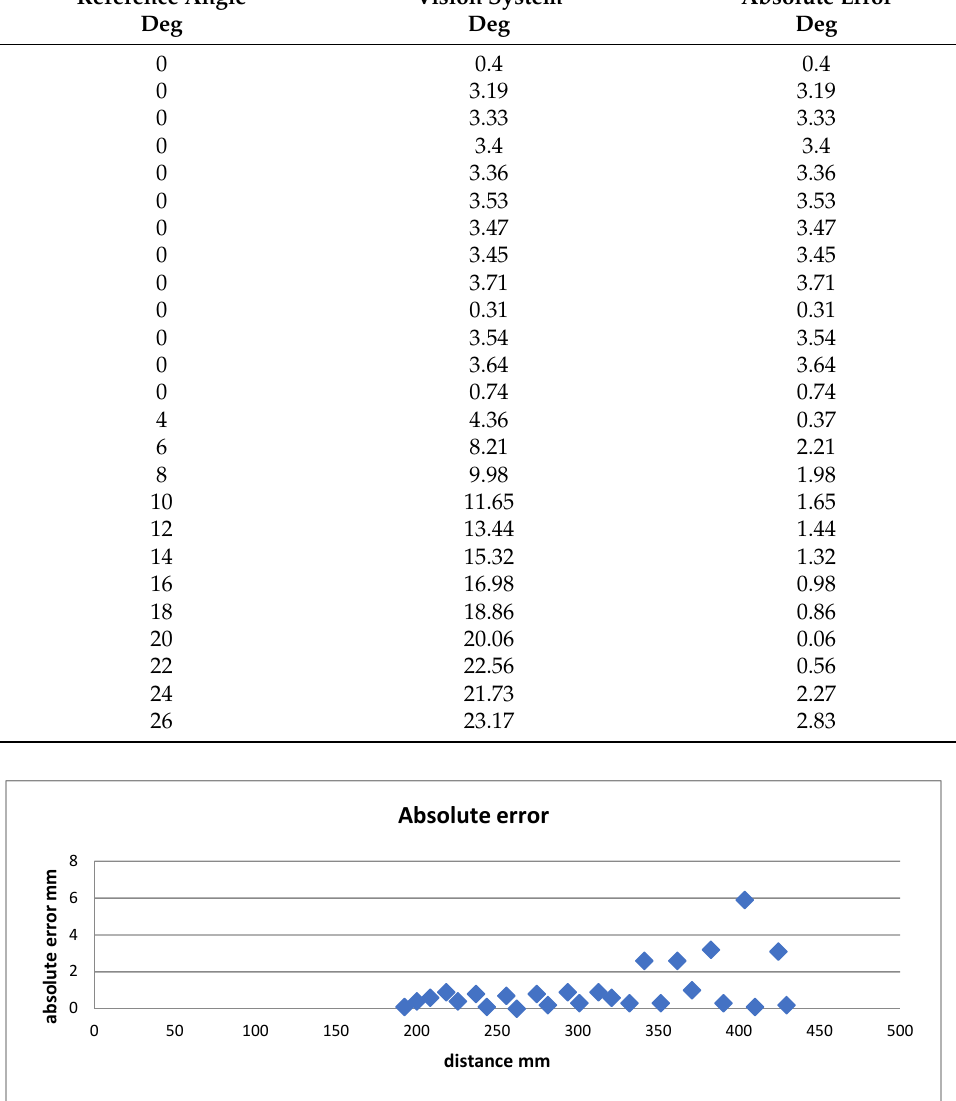
Table 3. Measurement of rotation around the y -axis by a vision system.